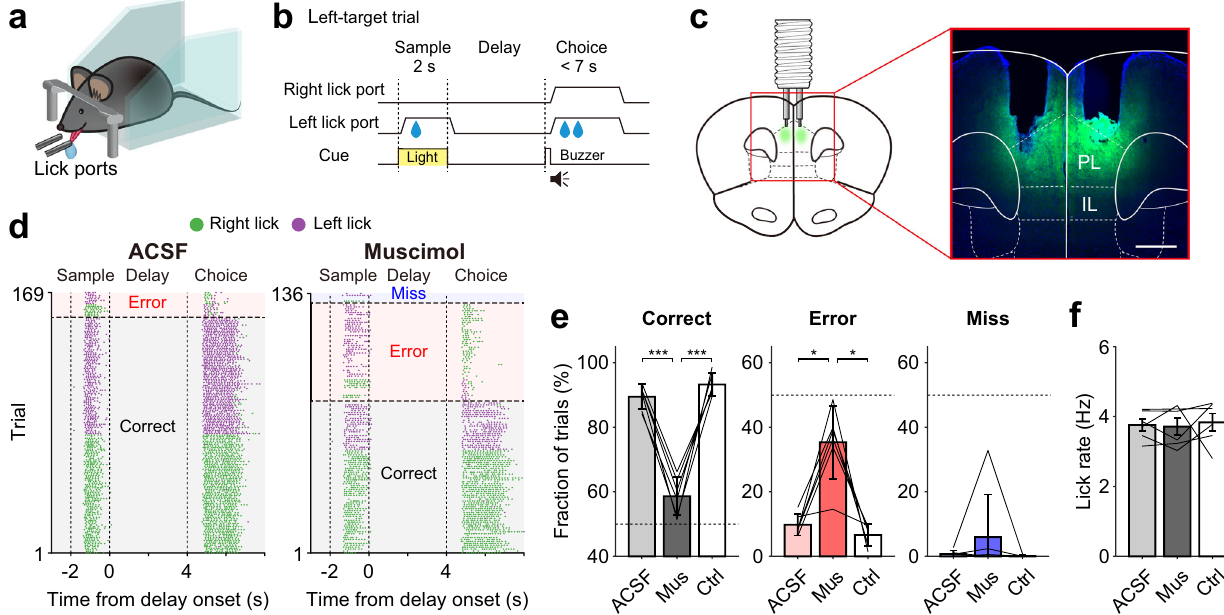
Fig. 1 mPFC inactivation impairs behavioral performance. a The experimental setting (custom-created image). Head- fi xed mice performed a delayed match-to-sample task. b Schematic for a left-target trial. Mice obtained a water reward by choosing the lick port presented during the sample phase (target) before a delay period. c Schematic (left) and a coronal brain section (representative of six mice; right) showing cannula tracks and the spread of fl uorescein (green) in the mPFC. PL prelimbic cortex, IL infralimbic cortex. Scale bar, 500 μ m. d – f Effects of mPFC inactivation on behavior under the 4-s